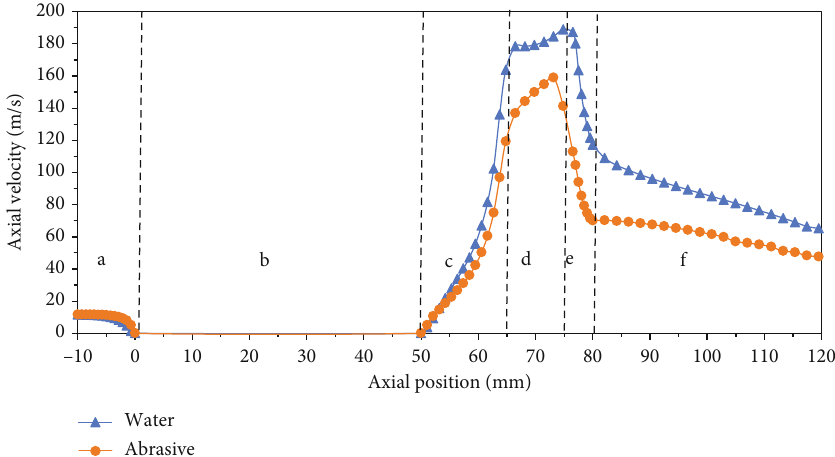
Figure 6: Axial velocity distribution of abrasive and water in swirling abrasive jet (a) inlet section, (b) swirling section, (c) contraction section, (d) cylindrical outlet section, (e) di ff usion section, and (f) external fl ow fi eld section.